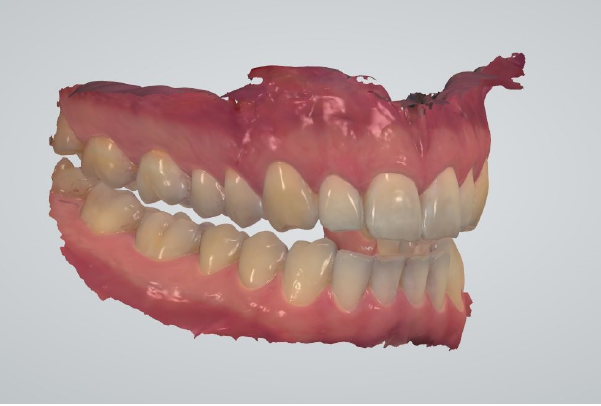
Figure 2. The digital impression of both dental arches with the fixed OVD.